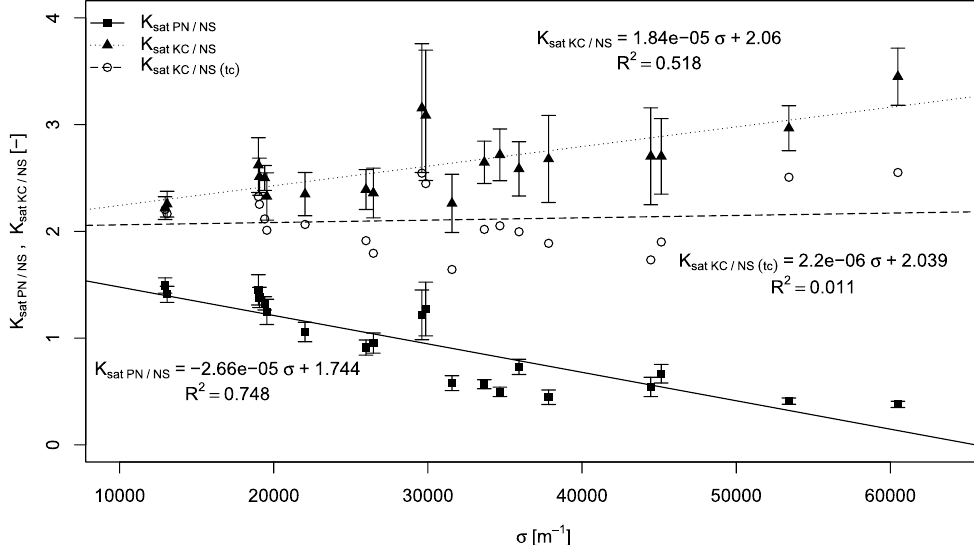
Figure 4. Relationship between the ratios of saturated conductivities determined by the pore network (K sat PN/NS ) and Kozeny–Carman (K sat KC/NS ) to saturated conductivities estimated by Navier–Stokes modeling (figure created using RStudio 1.3 software https ://rstud